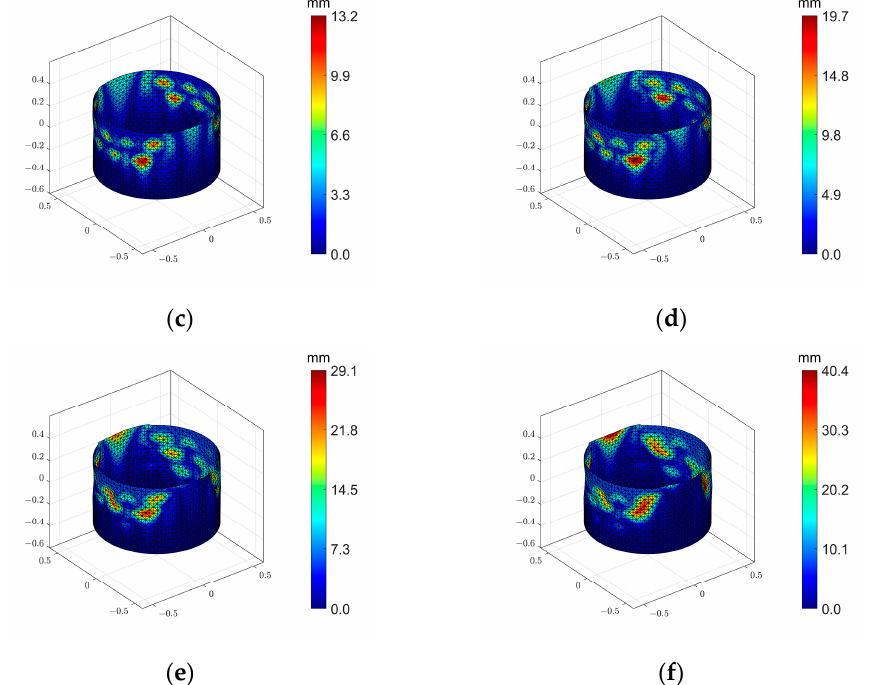
Figure 10. Postbuckling of 2 × 120° local axial compression: ( a ) before buckling, ( b ) first buckling, ( c – f ) second buckling.